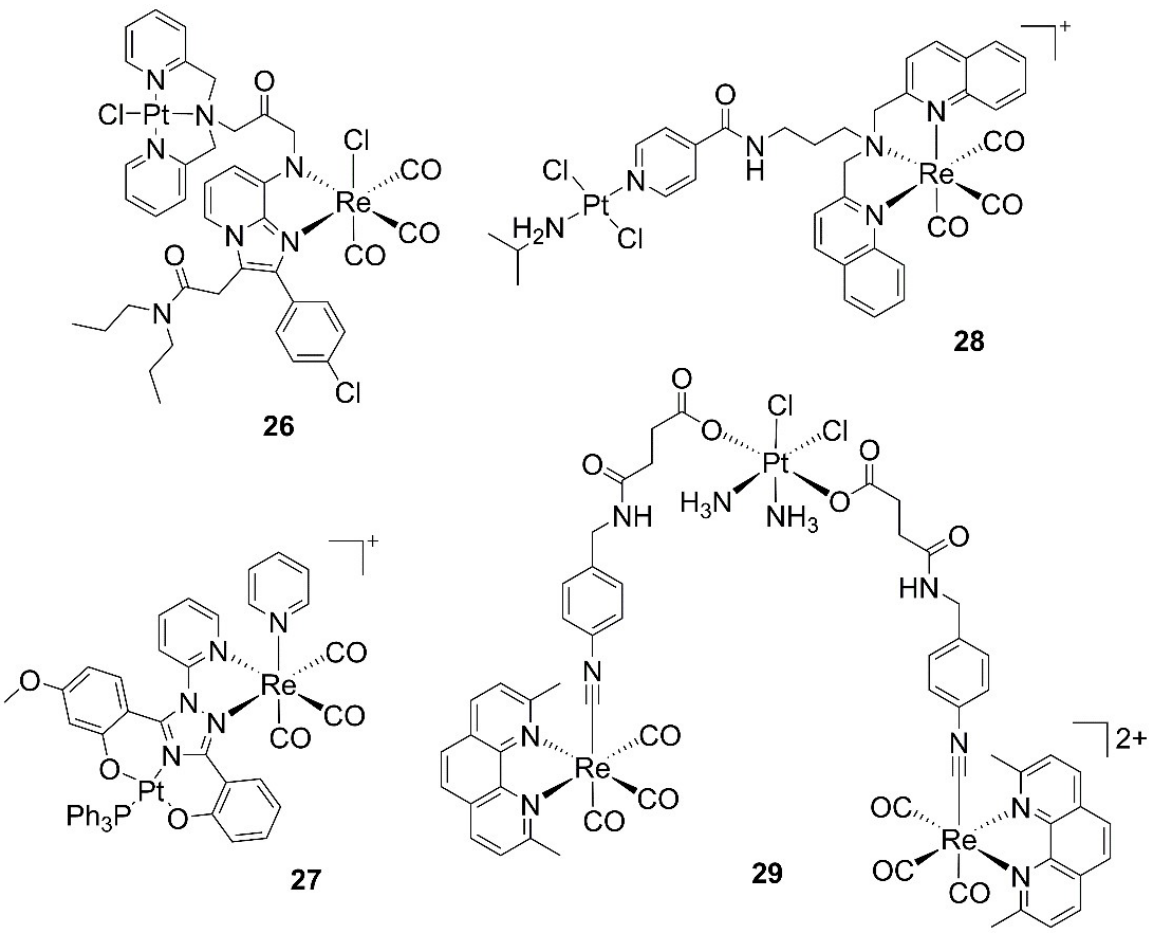
Figure 5. Structures of heteronuclear platinum–rhenium anticancer complexes.